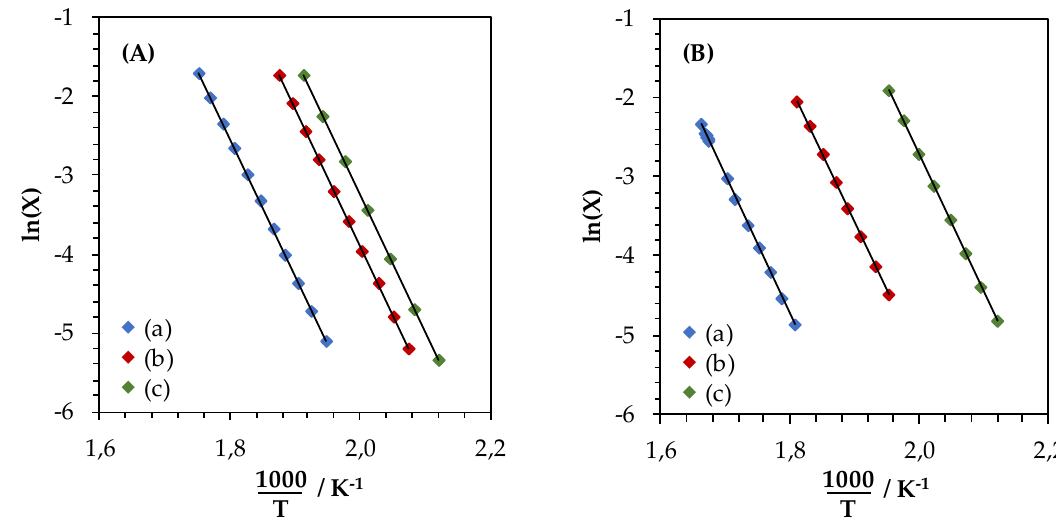
Figure 8. Arrhenius plots obtained at X < 20% for the toluene oxidation reaction over LaMnO 3.15 ( A ) and LaFeO 3 ( B ) samples: (a) SSR, solid state reaction; (b) HEBM, high-energy ball milling; (c) LEBM, low-energy ball milling.